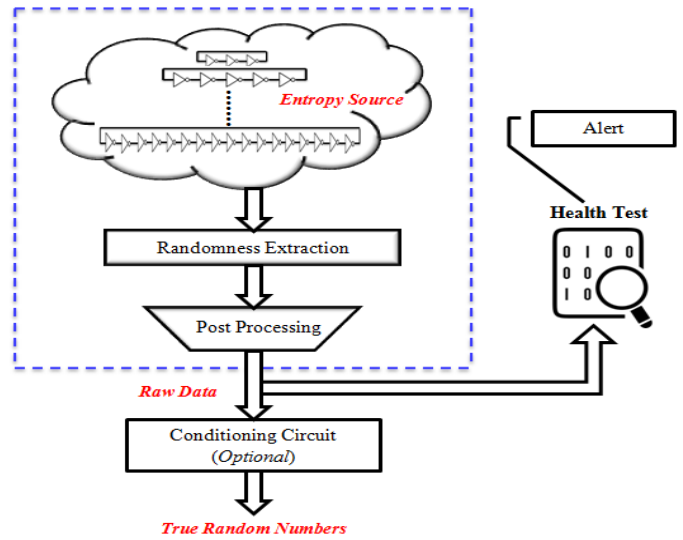
Figure 1. Pictorial representation of the proposed TRNG.